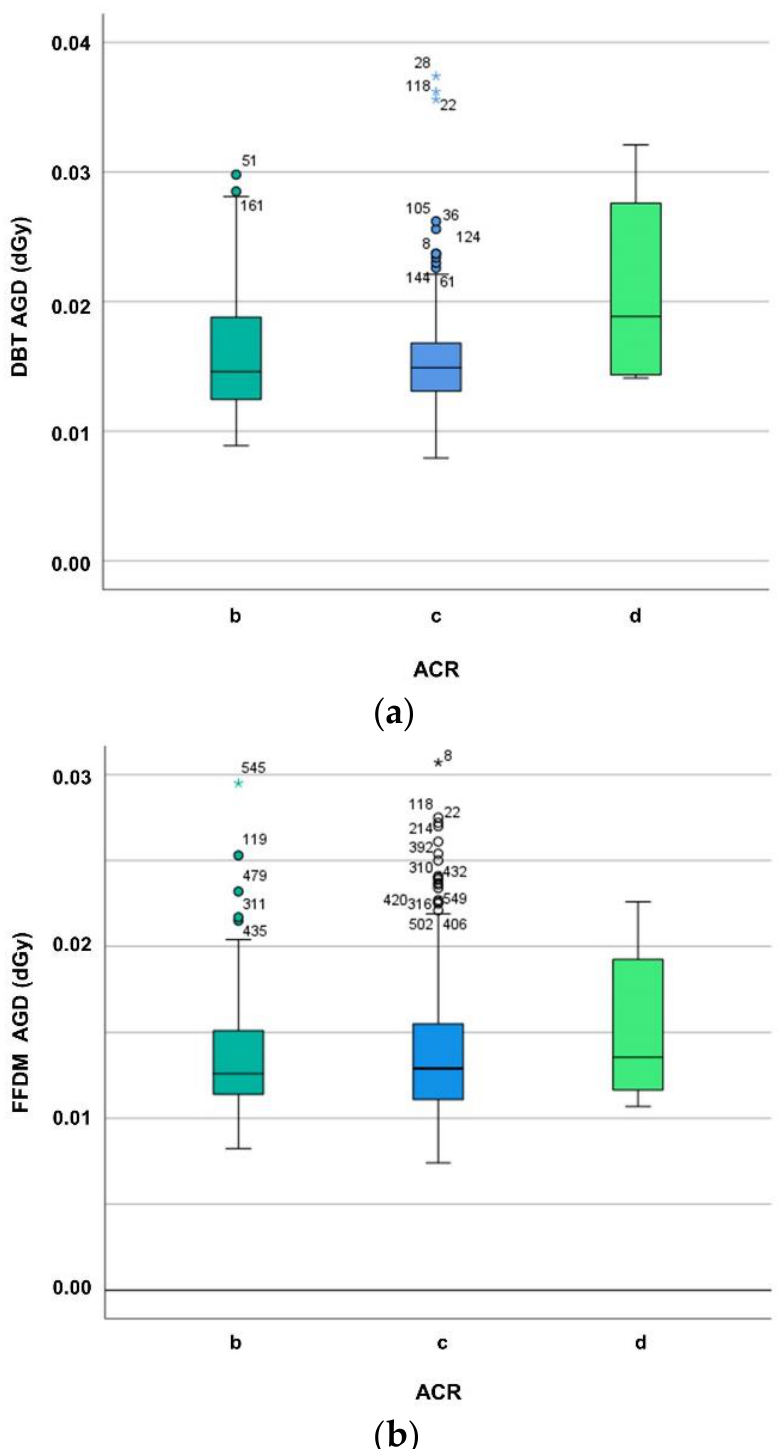
Figure 2. ( a ) Differentiating average glandular dose (in dGy) of digital breast tomosynthesis (DBT) for ACR breast density groups b–d. The MGD increase may be explained mainly by the automatic exposure control (AEC) which influences tube loading, kV, anode/filter combination, and breast composition such as breast density and thickness. ( b ) Differentiating average glandular dose (in dGy) of digital mammography (FFDM) for ACR breast density groups b–d. The MGD increase may be explained mainly by the automatic exposure control (AEC) which influences tube loading, kV, anode/filter combination, and breast composition such as breast density and